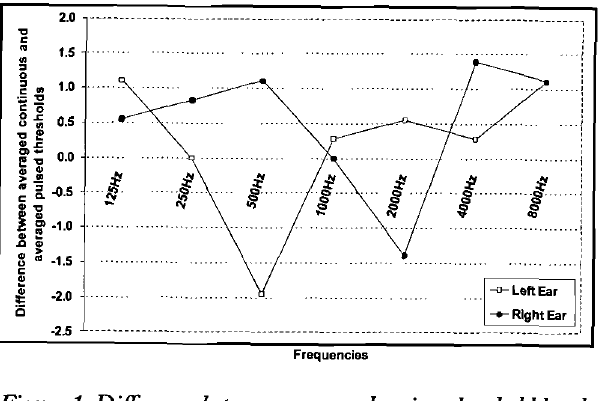
Figure 1: Difference between average hearing threshold levels o f continuous andpulsed tones in each ear (n=18) A difference value of zero, which was obtained at 250 Hz in the left ear and at 1000 Hz in the right ear, indicated no threshold difference between the two stimulus types as presented in Figure 1. Negative values indicated that lower thresholds were obtained for continuous tones. Continuous tones yielded better thresholds than pulsed tones at 500 Hz in the left ear and 2000 Hz in the right ear. Lower thresh­ olds were obtained for pulsed tones at all other frequencies for both ears. Therefore, pulsed tones yielded lower thresh­ olds than continuous tones for the majority of frequencies tested.